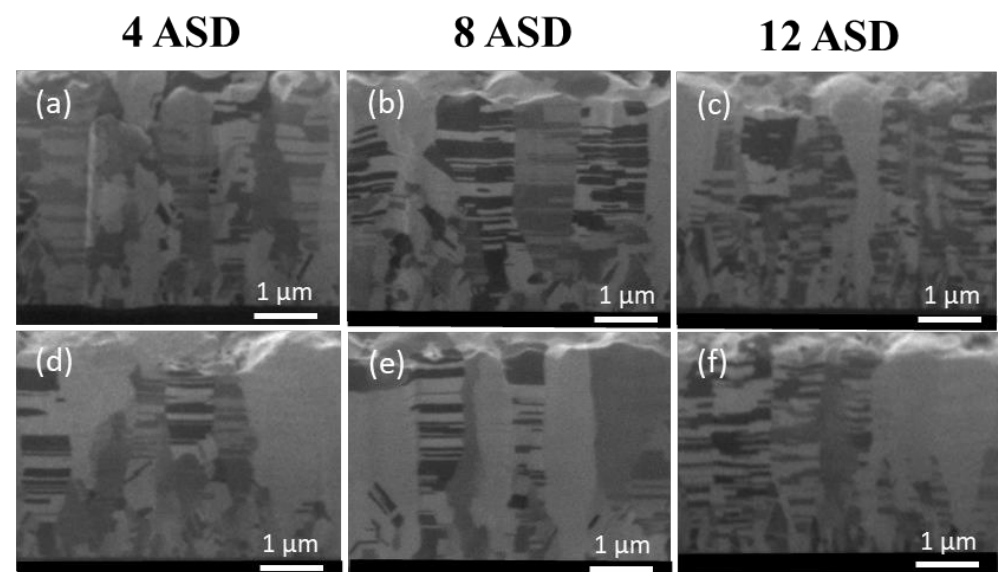
Figure 6. Cross-sectional FIB images of the as-fabricated ( a – c ) and annealed ( d – f ) nt-Cu films deposited with various current densities of 4, 8, and 12 ASD, respectively. The nt-Cu films were electrodeposited at 35 °C and the annealing was conducted at 200 °C for 10 h. Table 3. Degree of (111) orientation and grain size of the films deposited at 35 °C.